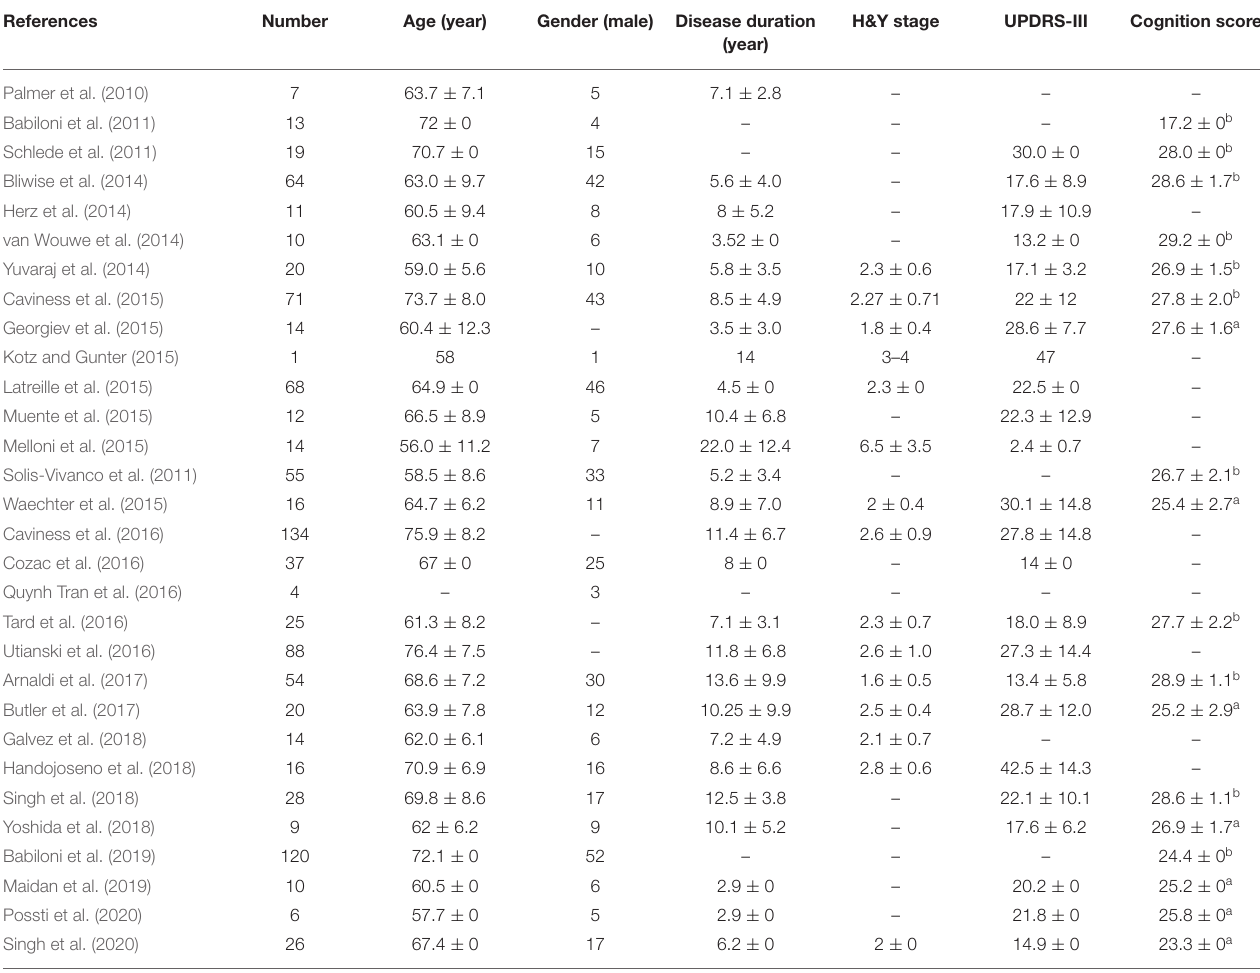
TABLE 1 | PD patient demographic characteristics and clinical scores (Mean ± SD) are